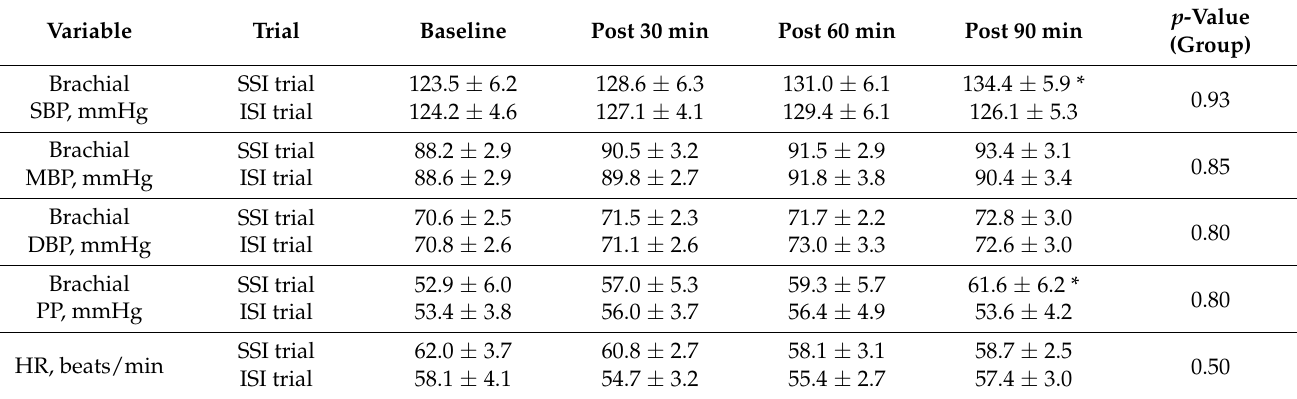
Table 2. Changes in brachial SBP, MBP, DBP, and HR before and after the ingestion of isomaltulose and sucrose. Variable